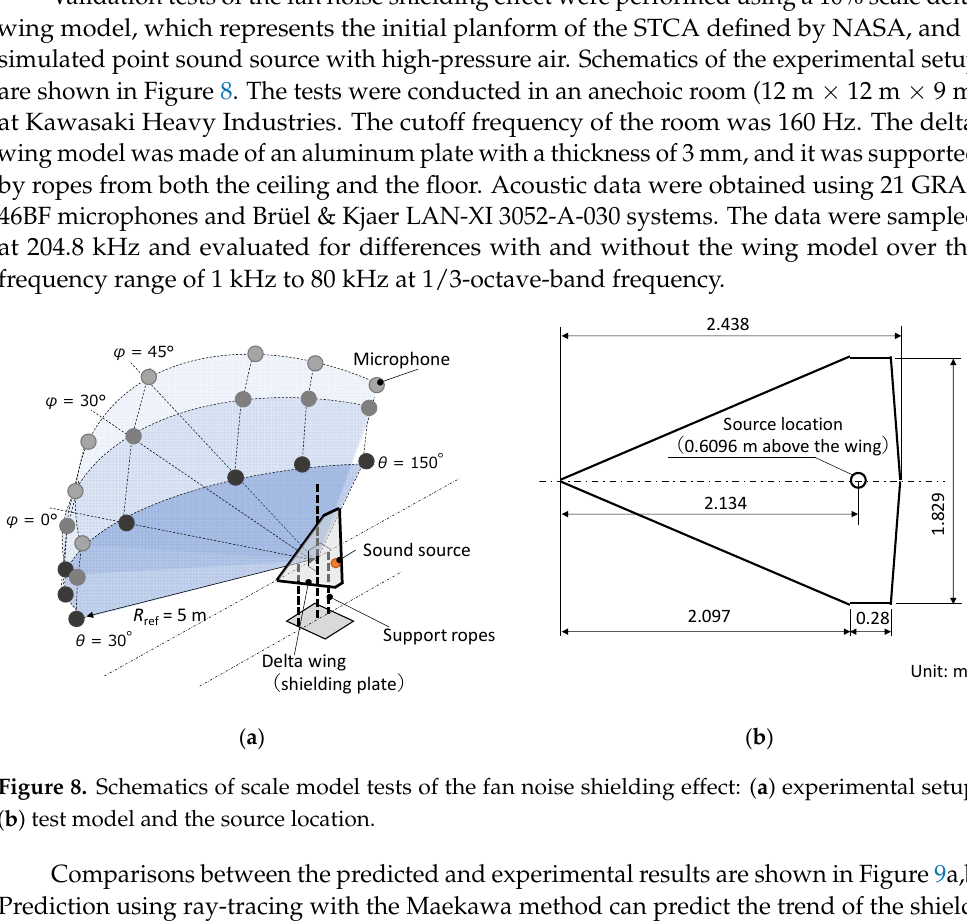
Figure 8. Schematics of scale model tests of the fan noise shielding effect: ( a ) experimental setup; ( b ) test model and the source location.